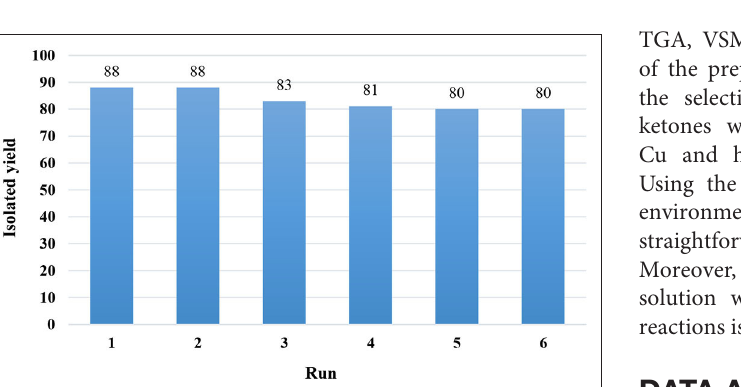
FIGURE 7 | Yields of products after several uses of recovered Fe 3 O 4 @PVA-Cu catalyst in the oxidation reaction of benzyl